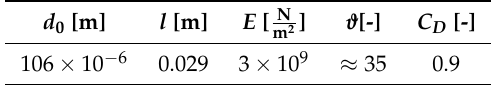
Table 2. Parameters of the sensor shaft for the simulation of the application